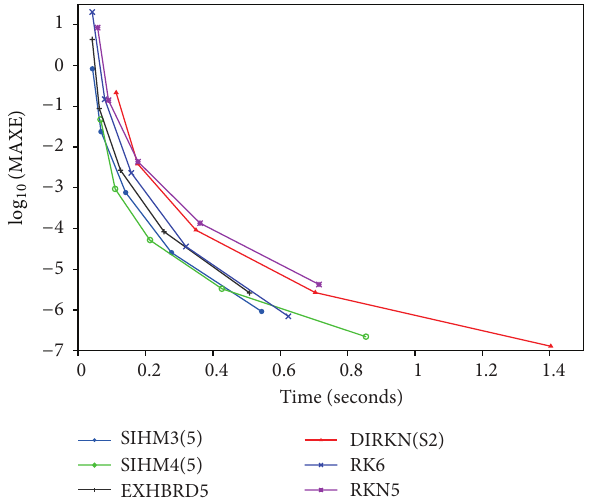
Figure 10: The efficiency curves for SIHM3 (5) and SIHM4 (5) methods for Attili problem with ℎ = 0.125/2 𝑖 , 𝑖 = 1,...,5 . (xi) EXHBRD4: a explicit three-stage fourth-order hybrid method derived by Franco [3].